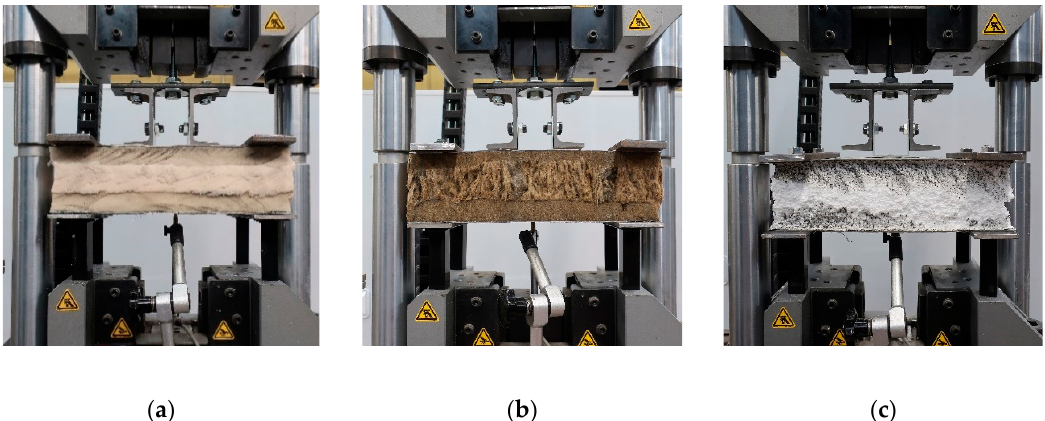
Figure 2. Test bed with test samples. Sandwich panel made of: ( a ) PIR foam core, ( b ) mineral wool core, and ( c ) expanded polystyrene core.